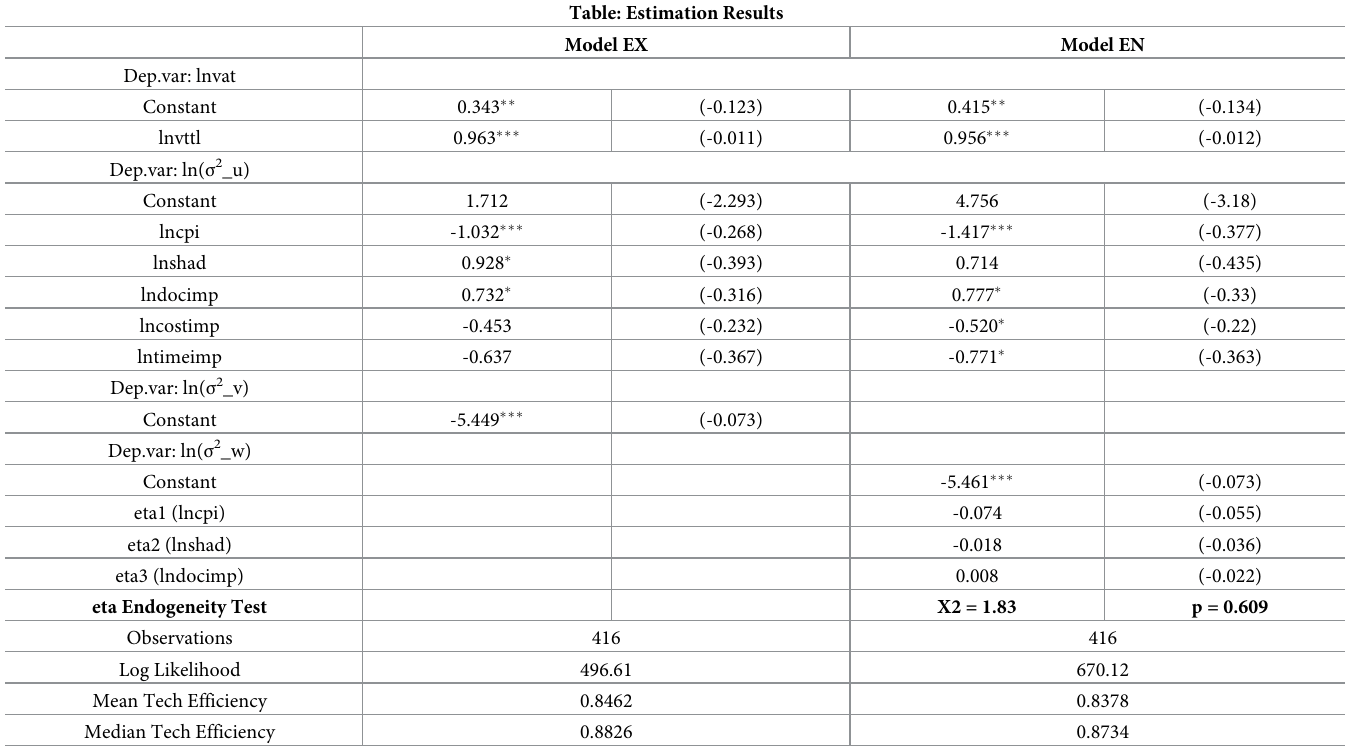
Table 10. Endogeneity test for the environmental variables ( Z variables) of the stochastic tax frontier model. Table: Estimation Results Model EX Model